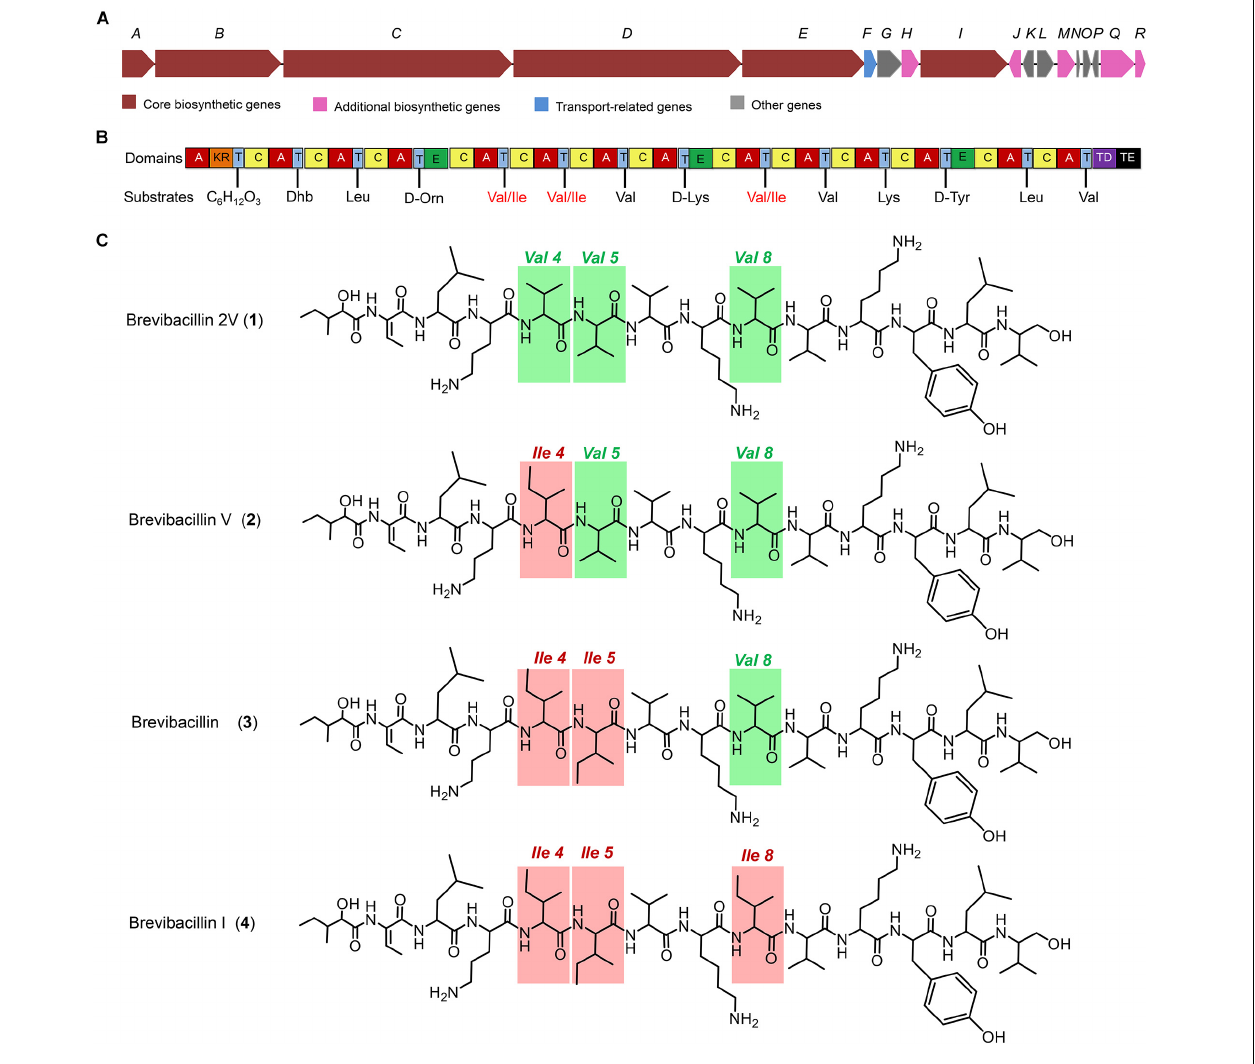
FIGURE 1 | The structures of brevibacillins and the predicted biosynthetic gene cluster. (A) The non-ribosomal peptide synthetase genes harbored by the Brevibacillus laterosporus DSM 25 genome. (B) The catalytic domains encoded by the gene cluster and the substrates incorporated by the respective